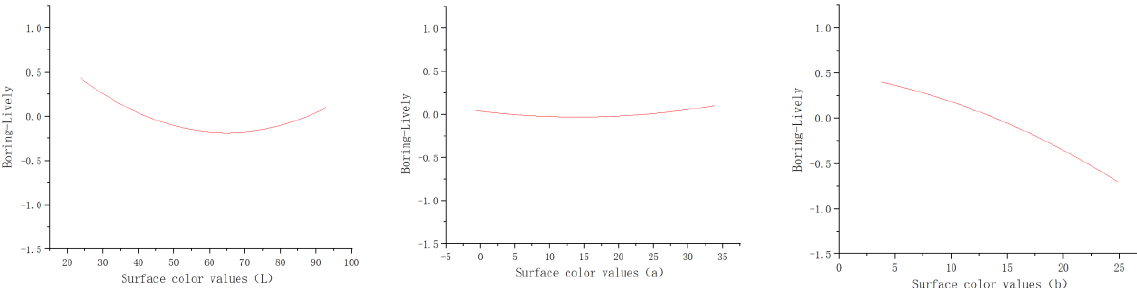
Figure 17. “Uncomfortable-Comfortable” and surface gloss polynomial fitting function.